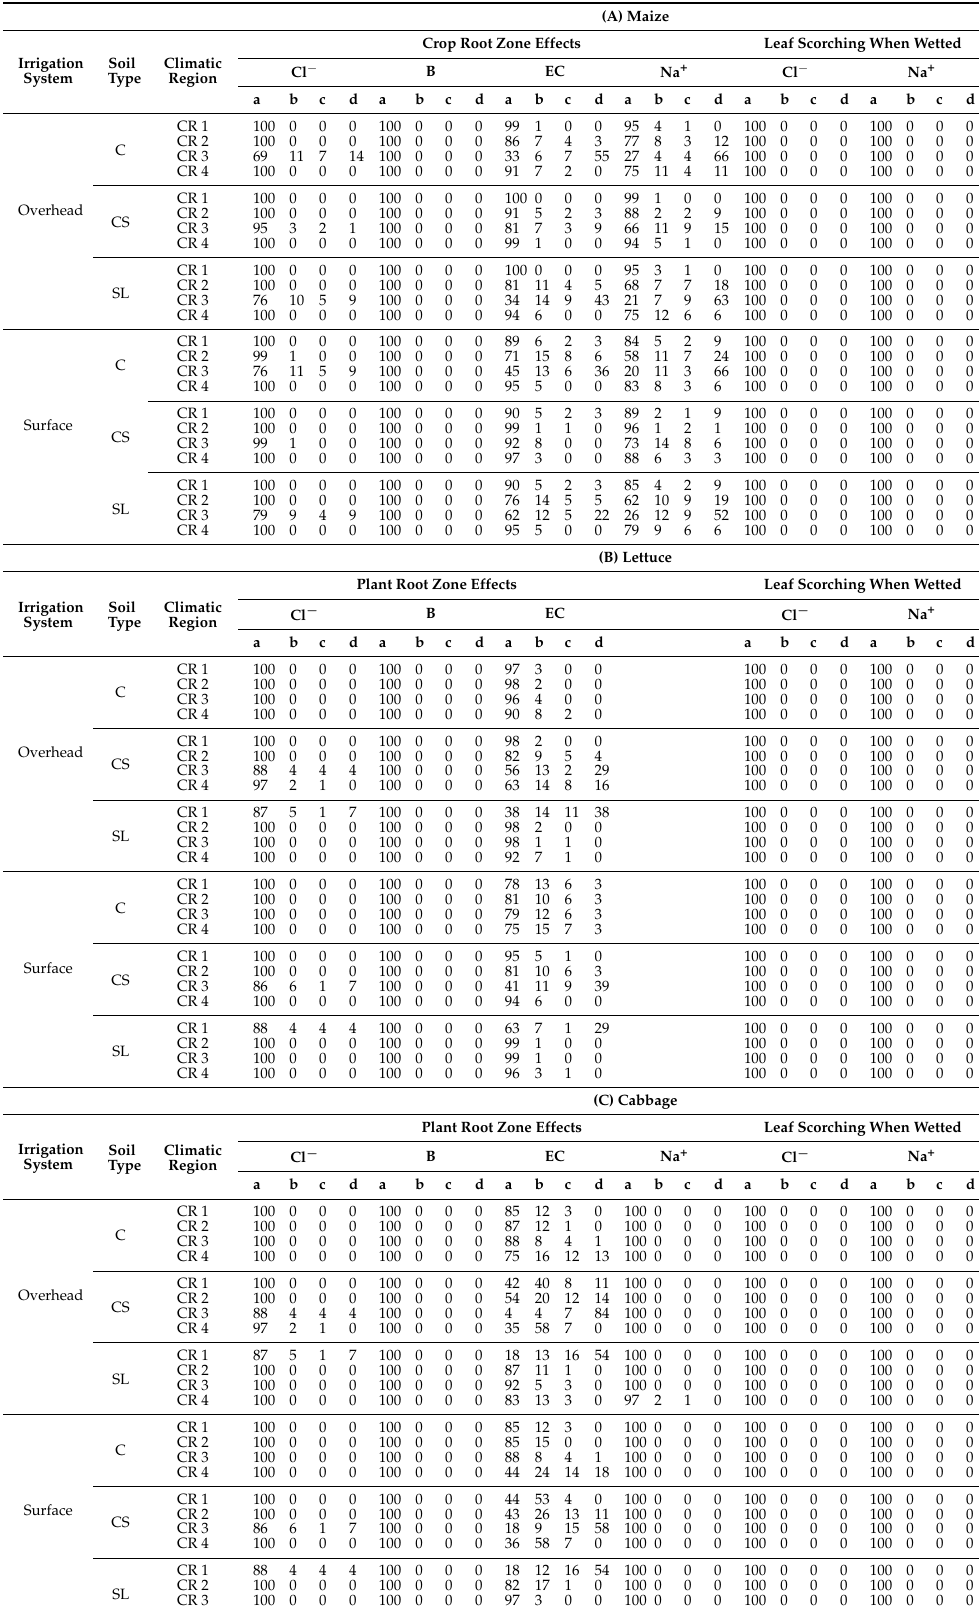
Table 6. Assessment of AF effluent for fitness-for-Use; impacts of irrigation system and soil type on maize (A), lettuce (B) and cabbage crop (C) yield and quality in different climatic regions ( n =